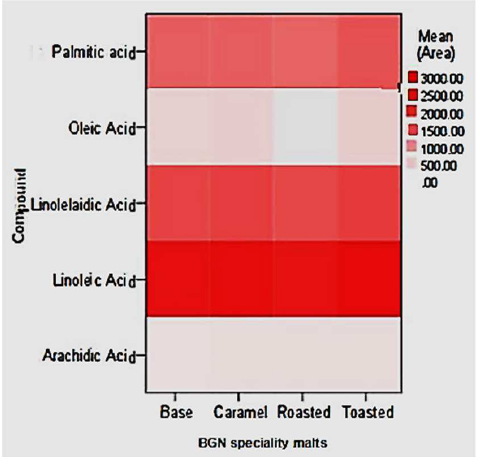
Figure 7. Heat plots of saturated, monosaturated, and polyunsaturated FAME of speciality Bambara groundnut malts. groundnut